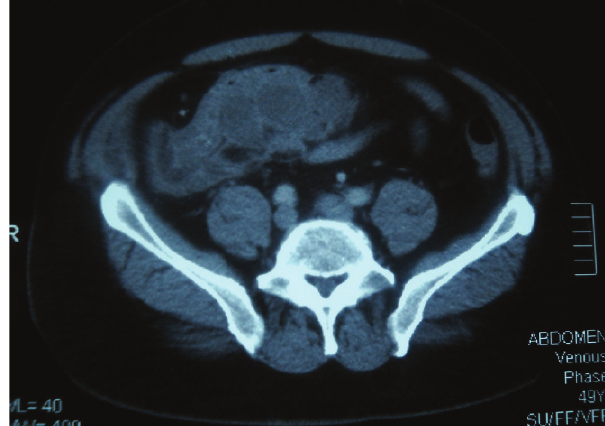
Figure 1 - Computed tomographic findings of a plastron or perforated appendicitis.